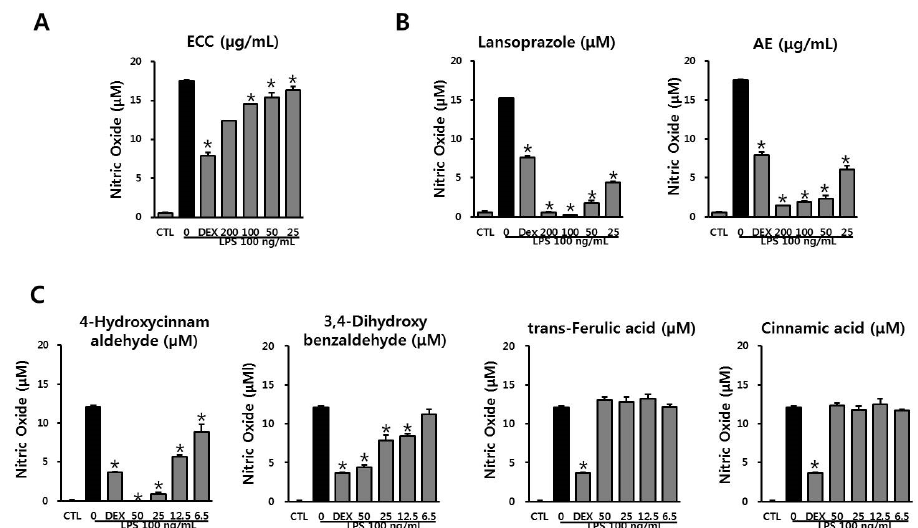
Figure 3. Anti-inflammatory effect of ECC and ECC components on NO production of RAW 264.7 macrophages. ( A ) Effect of ECC on NO production. ( B ) Effects of lansoprazole and Artemisia extract (AE) on NO production. ( C ) Effects of ECC components on NO production. RAW 264.7 cells were preincubated with ECC at indicated concentrations (200, 100, 50, and 25 μ g/mL, or 50, 25, 12.5, and 6.5 μ M) for 2 h, followed LPS (100 ng/mL) for 22 h. NO production was determined using Griess reagent. The data are presented as the means ± SD ( n = 3). * p < 0.05 compared to the LPS group. 3.4. Anti-Inflammatory Gene Expression of ECC and 4-Hydroxycinnamaldehyde